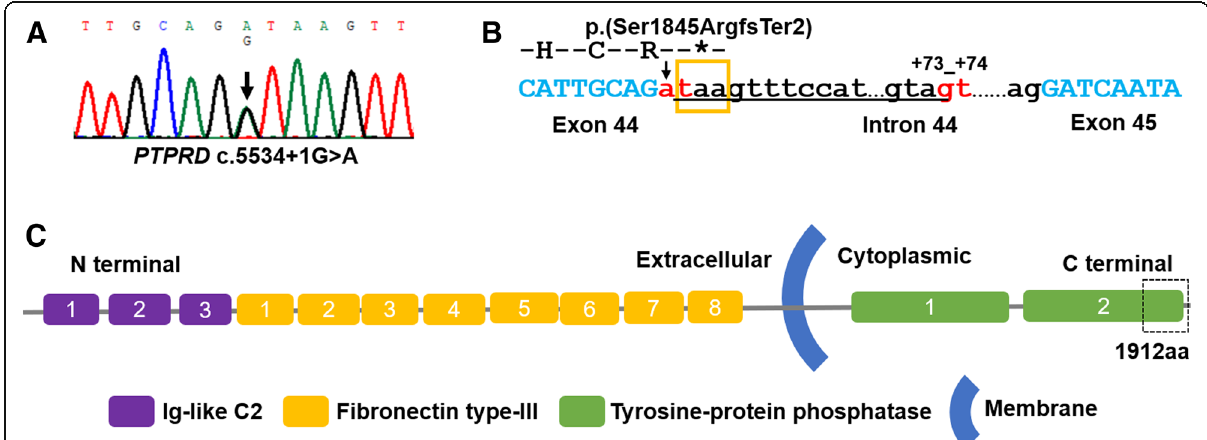
Fig. 3 The variant in PTPRD in Patient 11. ( a ) PTPRD sequence result of Patient 11. Arrow indicates the mutation site of c.5534 + 1G > A in PTPRD . ( b ) Predicted change in splice donor site of intron 44. The variant c.5534 + 1G > A disrupted the wild type splice donor site (arrow and red “ at ” ) and created a new potential splice donor site at c.5534 + 73_5534+ 74GT (red “ gt ” ). The abnormal splicing will cause retention of 72 nucleotides on upstream of the new donor site in intron 44 (underlined), create a premature stop codon at position 1846 (orange box), and lead to premature truncation of the protein p.(Ser1845ArgfsTer2). ( c ) PTPRD protein structure. PTPRD protein is a single-pass type I membrane protein and predicted to contain conserved function domains: three Ig-like C2 domains (Ig-like C2 type1, Ig-like C2 type2 and Ig-like C2 type3) (Purple), eight fibronectin type-III domains (Orange), and two tyrosine-protein phosphatase domains (Green) (https://www.uniprot.org/uniprot/P23468). As predicted, the truncated protein (p.(Ser1845ArgfsTer2)) will lack part of tyrosine-protein phosphatase 1 domain (dotted